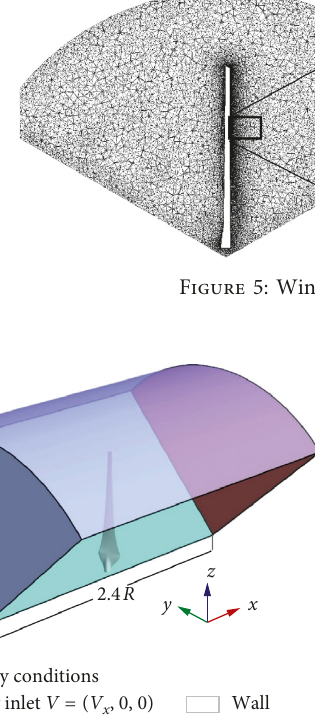
Figure 6: Fluid volume for aerodynamic simulation and boundary conditions used on CFD simulation.